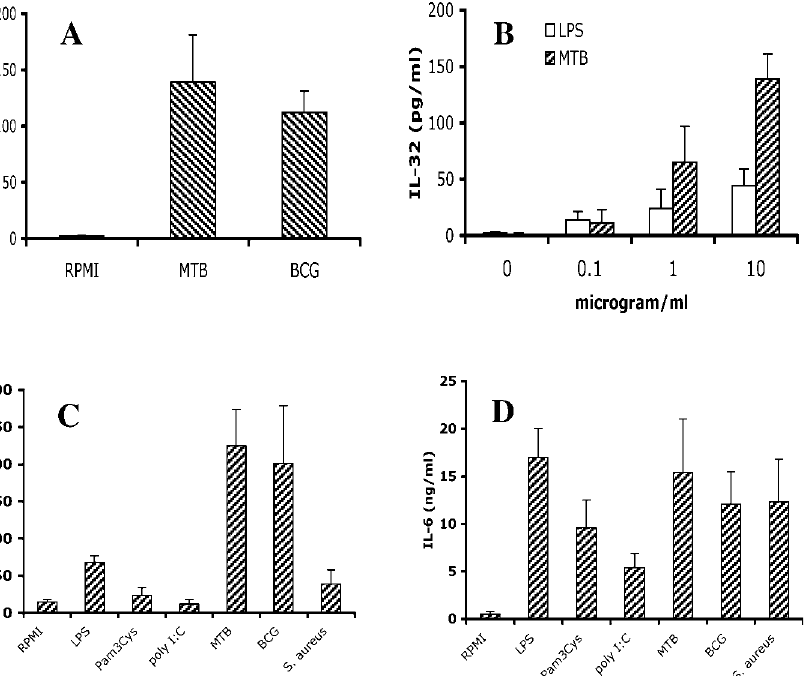
Figure 1. Stimulation of IL-32 by Mycobacteria (A) Whole blood was diluted 1:4 with RPMI and stimulated with 10 l g/ml sonicated M. tuberculosis (MTB) or M. bovis BCG (BCG). Triton X-100 (0.5%) was added 24 h later, and IL-32 concentration was measured by ECL. (B) Stimulation of freshly isolated PBMCs with various concentrations of LPS or sonicated M. tuberculosis stimulated IL-32 synthesis in a dose-dependent manner. (C and D) Freshly isolated PBMCs were stimulated with TLR4 (LPS, 100 ng/ml), TLR2 (Pam3Cys, 10 l g/ml), TLR3 (poly I:C, 5 l g/ml), M. tuberculosis , M. bovis BCG, or S. aureus (all at 1 3 10 7 microorganisms/milliliter, heat-killed). After 24 h of stimulation, LPS-, M. tuberculosis–, and M. bovis BCG–stimulated production of IL-32 (C) or IL-6 (D) was measured by ECL. Data are presented as means 6 SEM ( n ¼